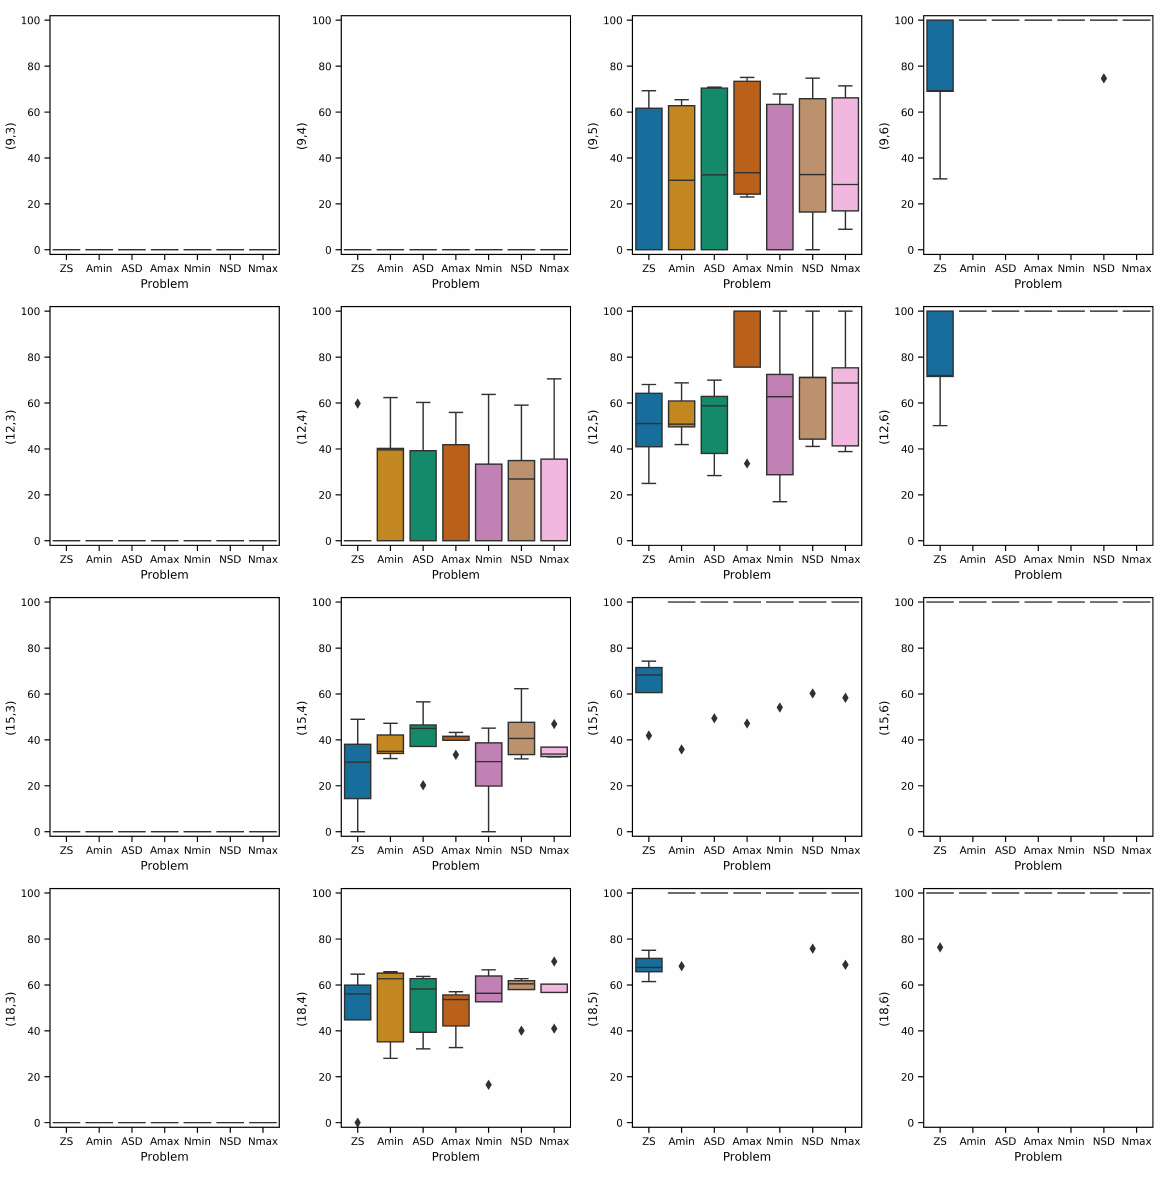
Figure 12. Box plots of the gaps in Table 4 (with J = 3, . . . ,6 for the four columns and K = 9,12,15,18 for the rows of